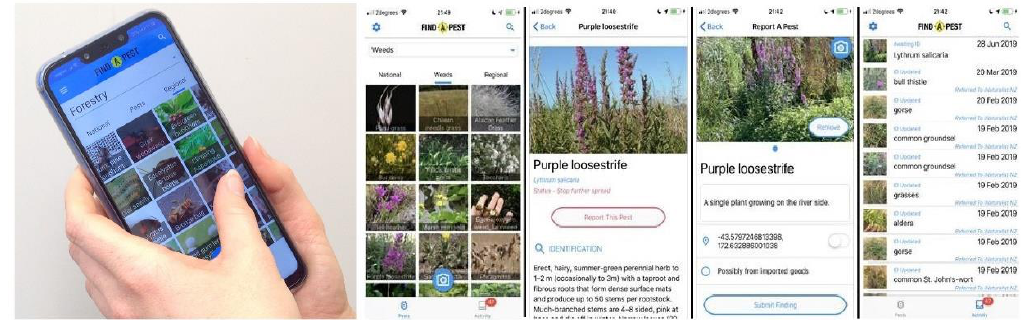
Figure 4. The resultant model in use for forestry and some screenshots from the Find-A-Pest app, including gallery, identification, submission and activity screens for regional weeds.